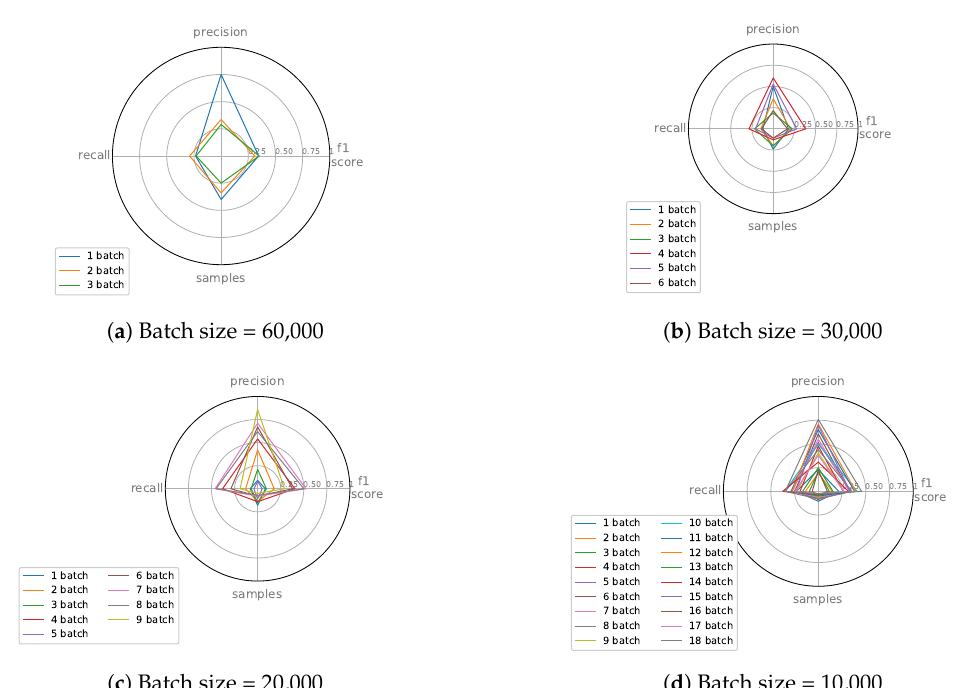
Figure 7. Radar graph with precision, recall, F1-score, and number of samples (normalized) for the Mining Pool class.